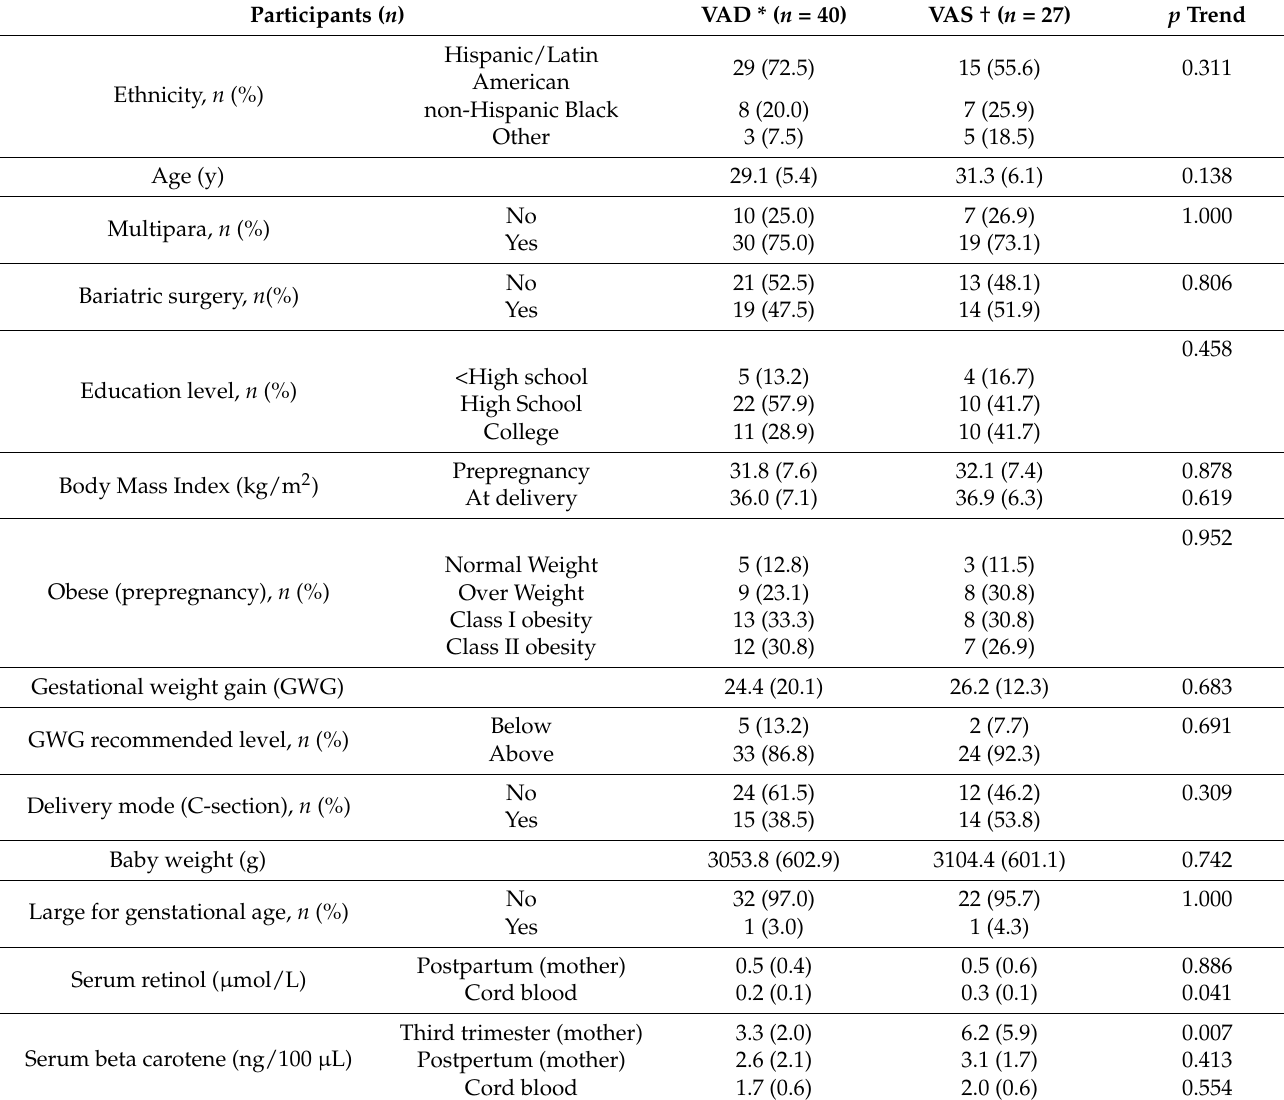
Table 1. Demographic information of the participants by serum retinol levels of the Bronx